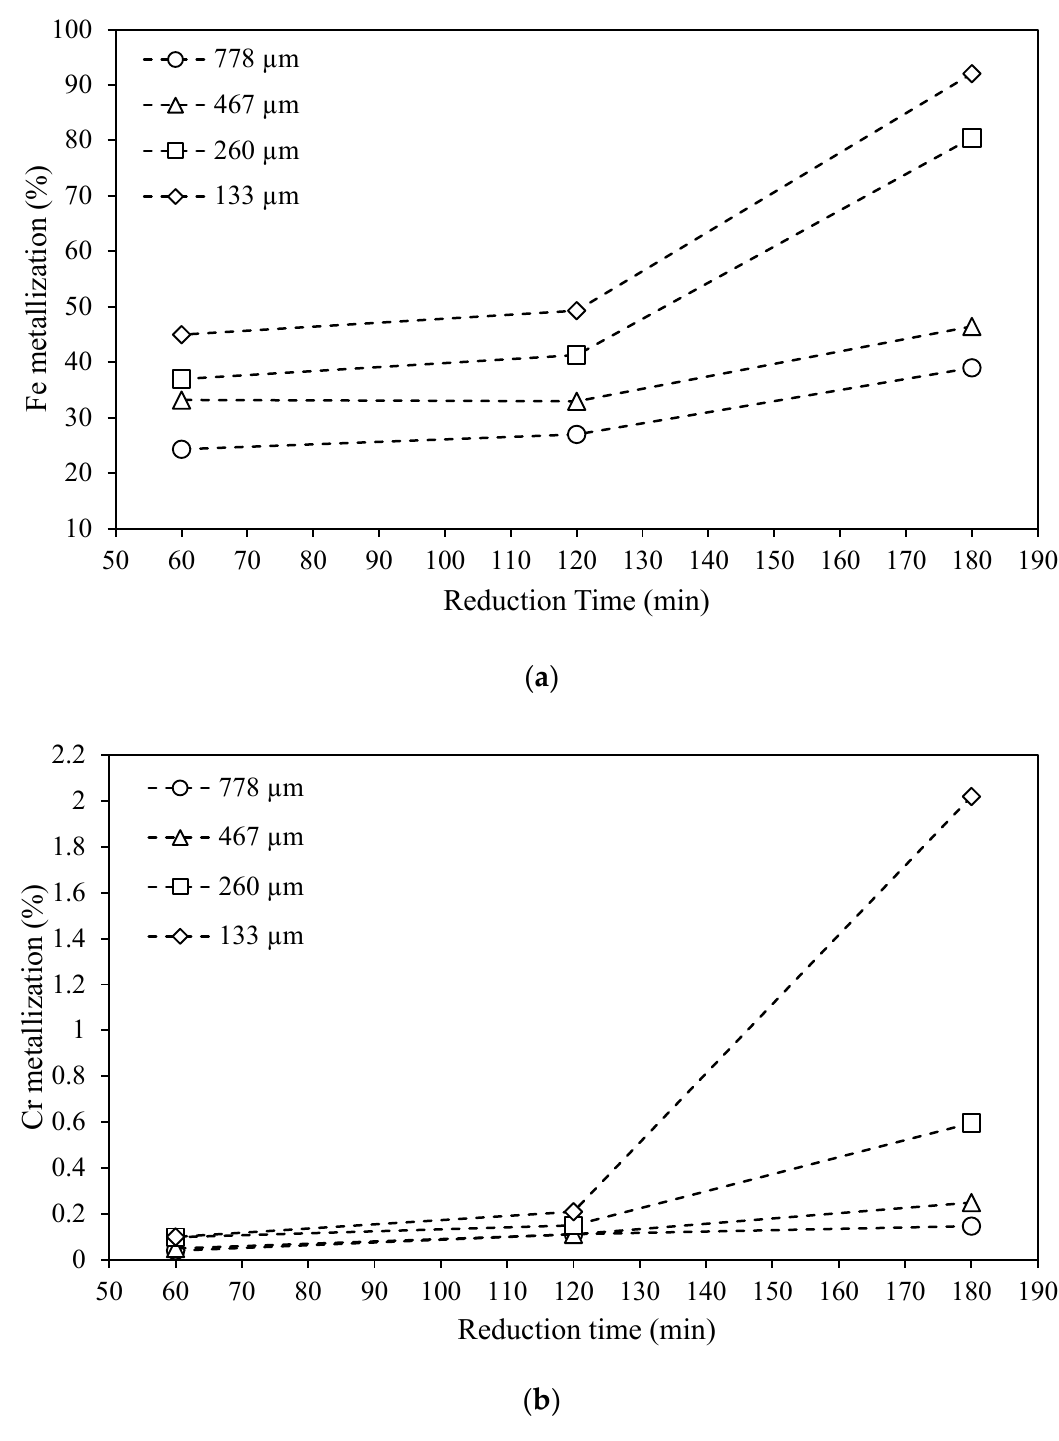
Figure 7. Effect of reduction time on the Fe ( a ) and Cr ( b ) metallization. All size-fractioned chromite samples were reduced at 1100 °C for 60, 120, or 180 min at a 750 mL/min hydrogen flow rate. According to Figure 7a,b a relatively insignificant change in the Fe and Cr metallization % was observed for the samples reduced for 60 and 120 min. However, samples reduced for 180 min showed a significant increase in metallization when compared to samples reduced for 120 min. The Fe and Cr metallization % for the smallest size fraction (d 90 of 133 µ m) increased from 39.0 to 92.1% and 0.1 to 2.0%, respectively, as the reduction time